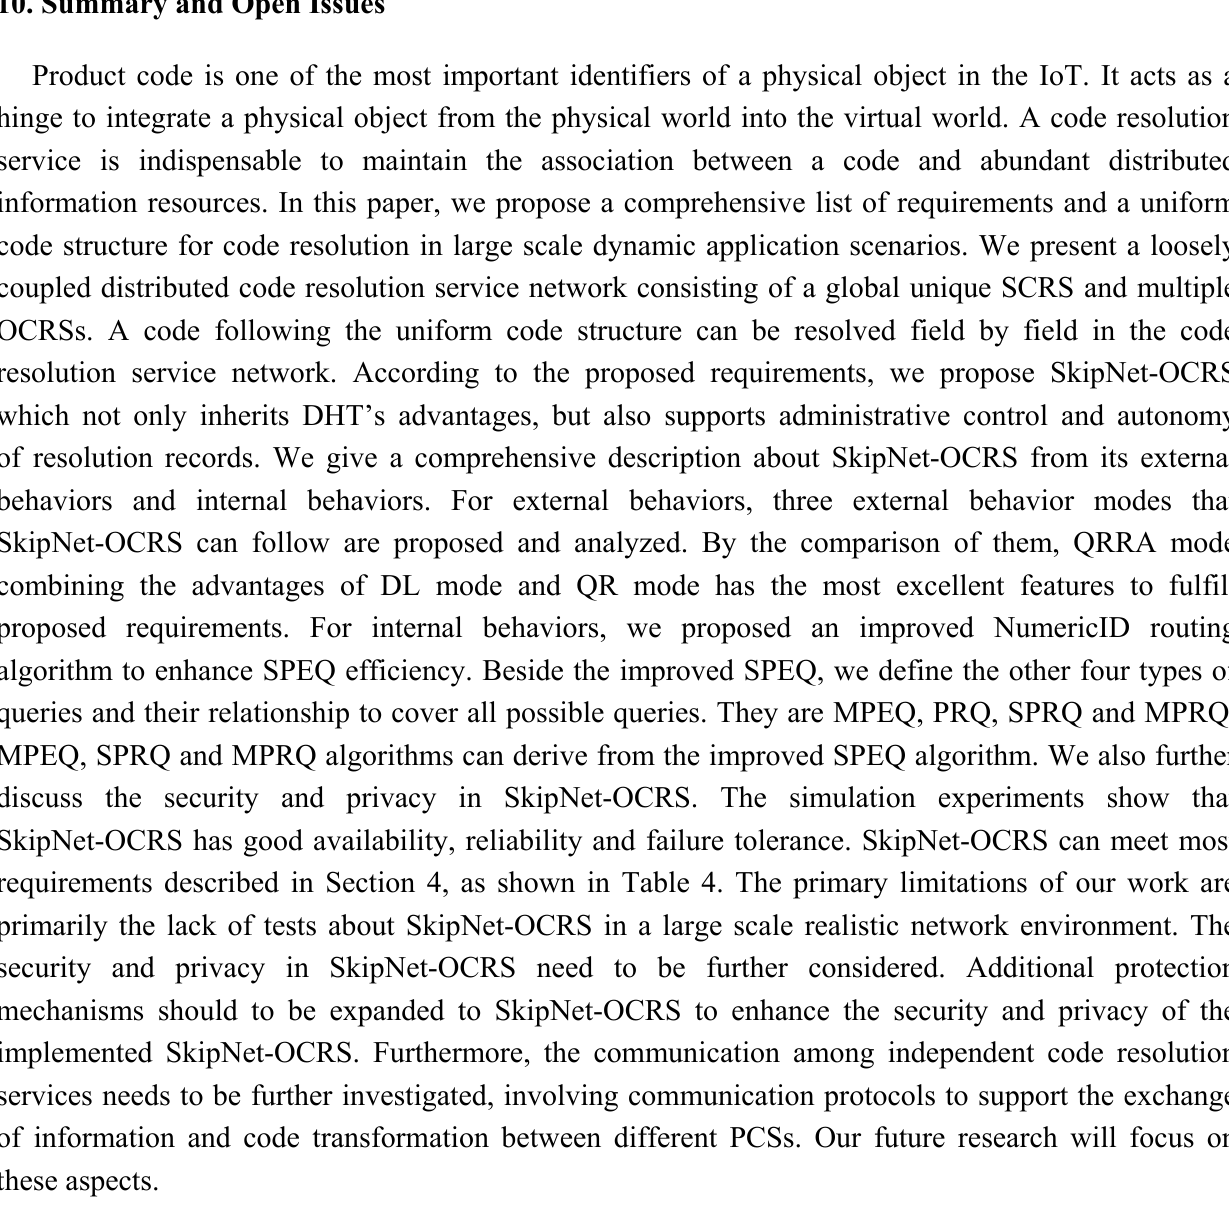
Table 4. Fulfillment of requirements. “ ● ” represents a RQ is satisfied completely. “ ○ ” represents a RQ is satisfied partly, additional mechanism is needed to full meet the RQ.EBs and IBs represent “external behaviors” and “internal behaviors”